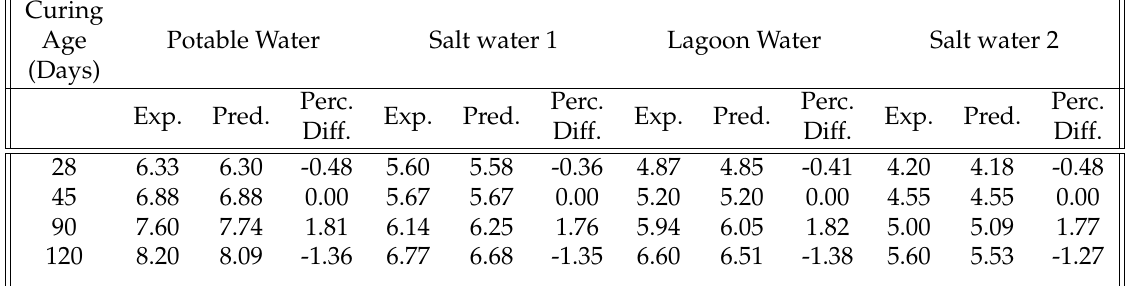
Table 11. Validation of developed models for the flexural strength of concrete cured in different curing medium Curing Age Potable (Days)